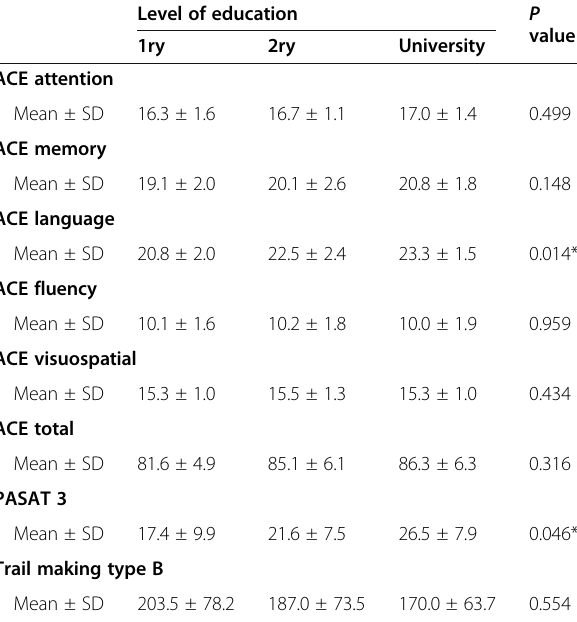
Table 4 Comparison between patients distributed according to MS course regarding mean cognitive scales